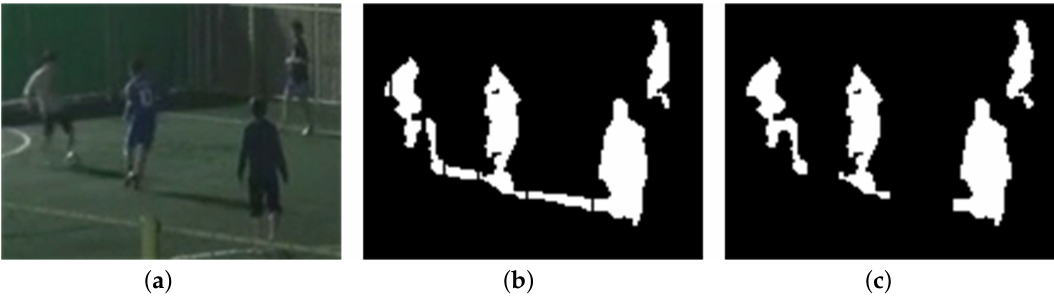
Figure 14. Shadow removal result 3 for multiple foreground objects (140 × 105 pixels from sequence